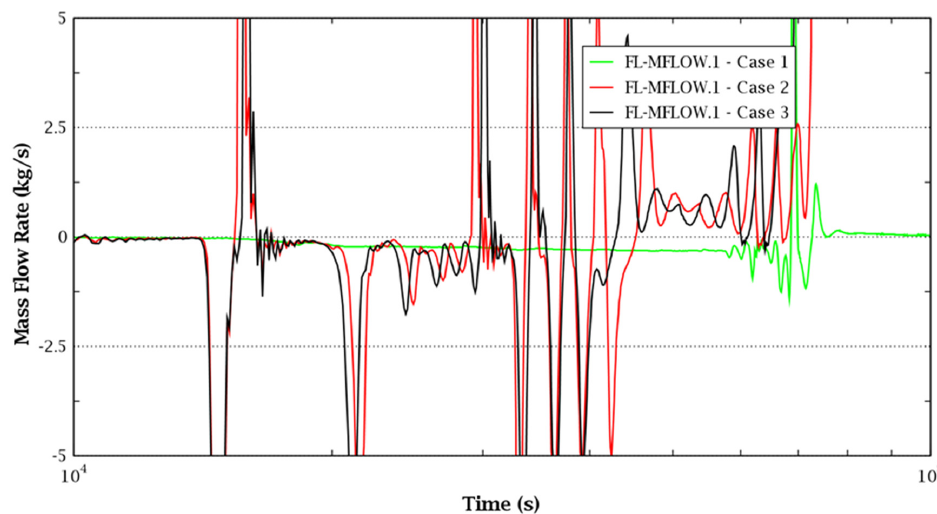
Figure 13. Water mass flow rate in the loop: 10 4 –10 5 s.